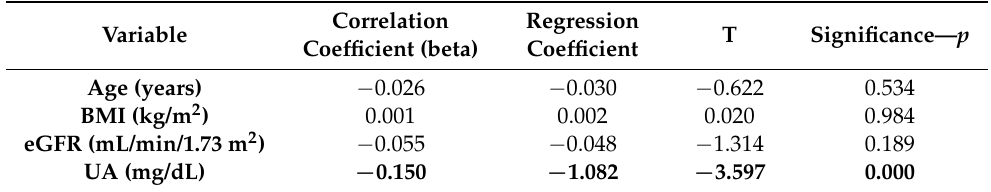
Table 3. Results of the multiple regression analysis for EF prediction before backward stepwise elimination of insignificant variables.